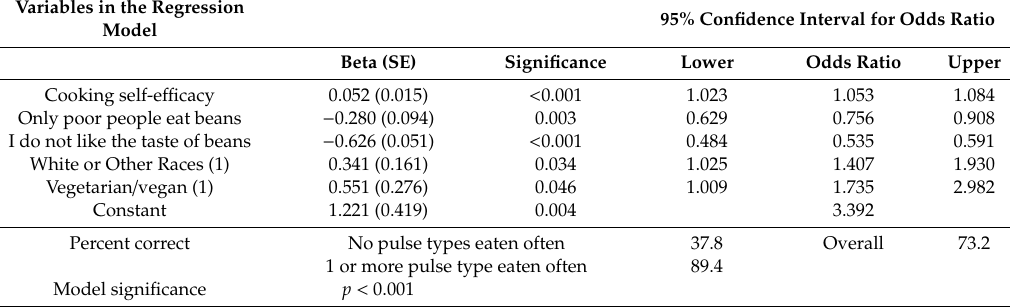
Table 5. Logistic regression model of predictors of pulse type consumption of students enrolled at a Midwestern US university ( n =